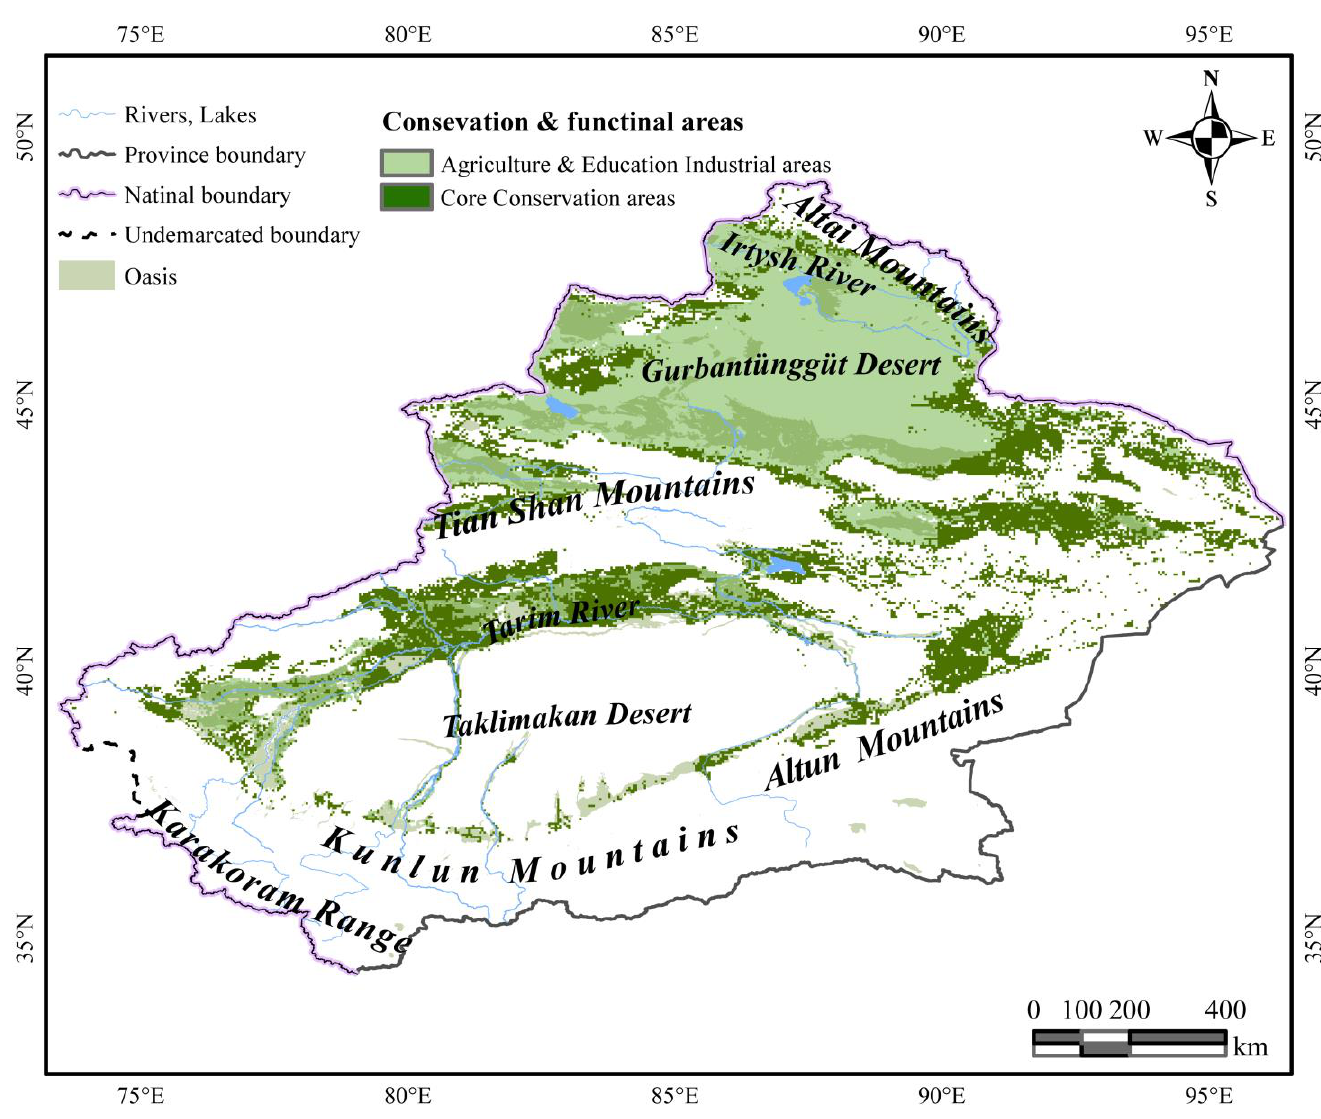
Figure 8. The conservation and functional areas based on the changing trend of HO (host factors only) strategy in climatic changes. The low and medium suitable habitats are identified as core conservation areas because of their sensitivity, and the highly suitable habitats are identified as agriculture and education industrial areas because of their adaptability.